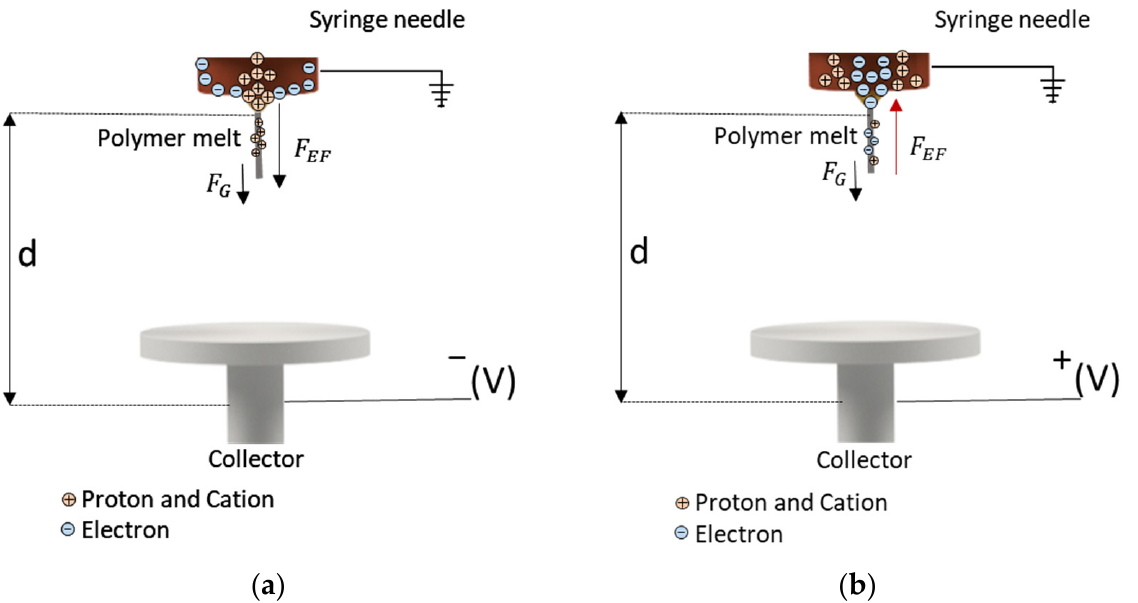
Figure 5. Motion of charges with a grounded syringe needle tip and ( a ) a negatively charged collector or ( b ) a positively charged collector. F G = gravitational force. F EF = electrical field force.